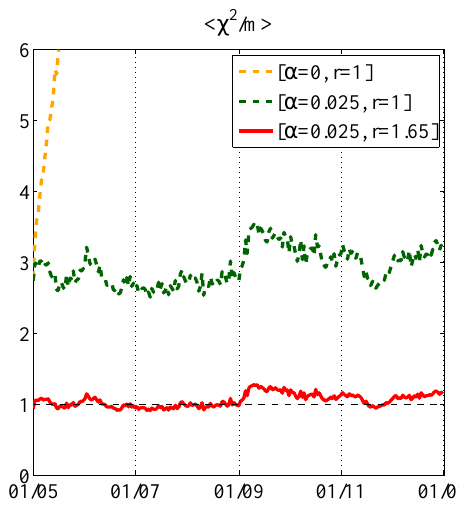
D E χ 2 /m Figure 2. evolution for the EnKF experiments using [ α = 0 ,r = 1 ] (orange dashed line), [ α = 0 . 04 ,r = 1 ] (green dashed) and Fig.2: (cid:10) χ 2 /m (cid:11) evolutionfortheEnKFexperimentsusing [ α =0 , r =1] (orangedashedline), [ α =0 . 04 , r =1] (green [ α = 0 . 04 ,r = 1 . 6 ] (red solid) for the period from 00:00UTC on dashed),and [ α =0 . 04 , r =1 . 6] (redsolid).fortheperiodfrom00UTCon1May2008to00UTCon1January2009. 1 May 2008 to 00:00UTC on 1 January